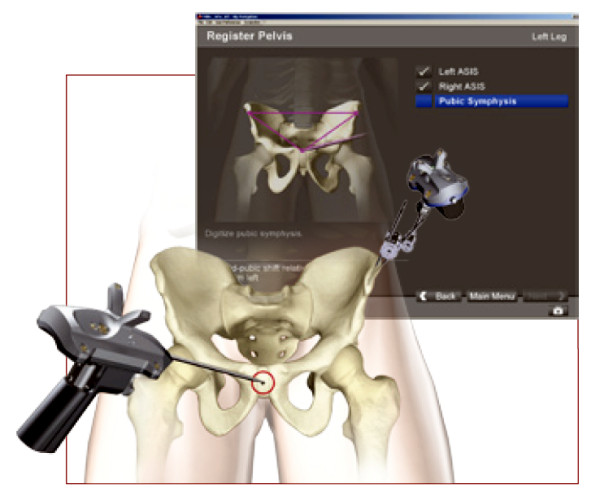
Once the Schanz screw was inserted into the ipsilateral anterior superior iliac, spine and the pelvic navigation tracker was attached, bony landmarks (ASIS, pubic, tubercle) were determined and digitalized with a metal pointer.